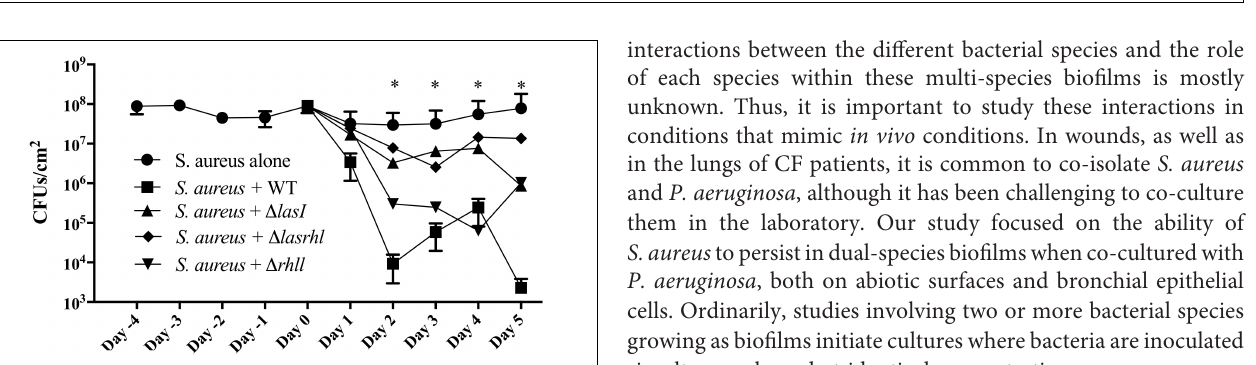
found when in co-culture with other QS mutants ( Figure 7